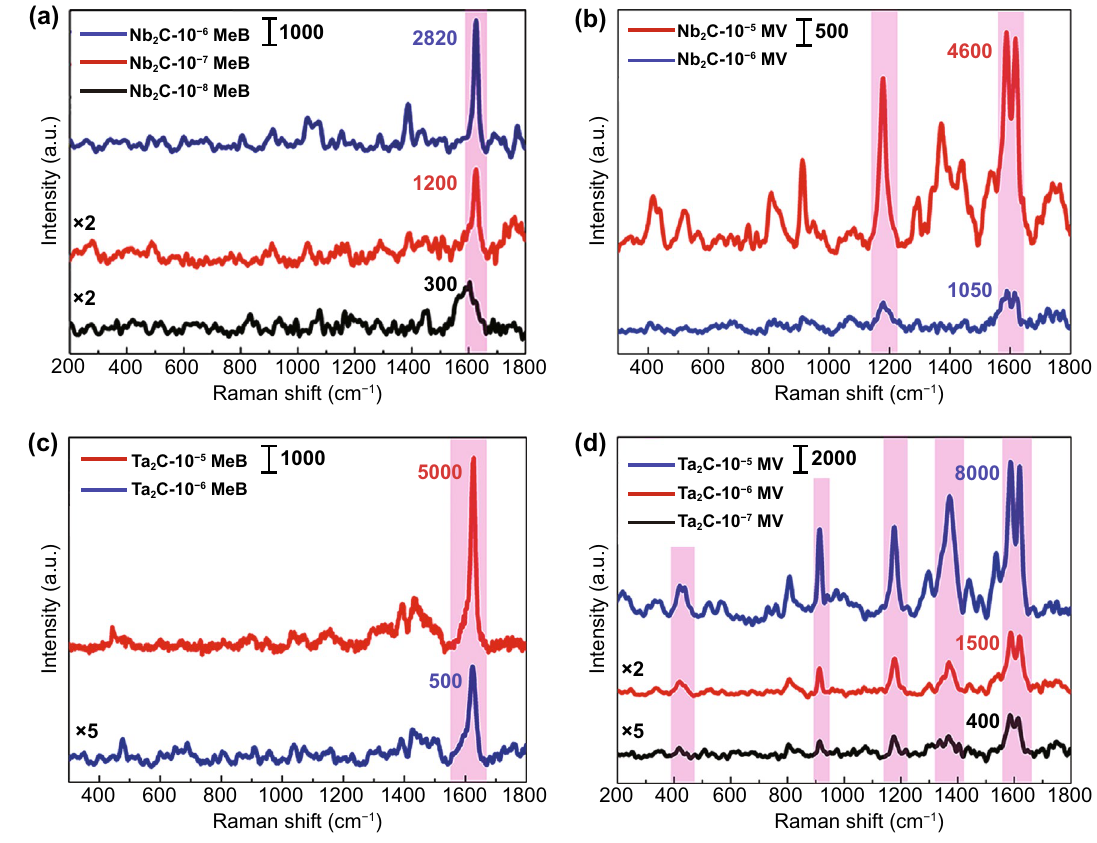
Fig. 5 a Raman spectra of MeB with three different concentrations, 10 −6 M, 10 −7 M and 10 −8 M on Nb 2 C NSs substrates. b Raman spectra of 10 −5 M and 10 −6 M MV on Nb 2 C NSs substrates. c Raman spectra of 10 −5 M and 10 −6 M MeB on Ta 2 C NSs substrates. d Raman spectra of MV with three different concentrations of 10 −5 M, 10 −6 M and 10 −7 M on Ta 2 C NSs